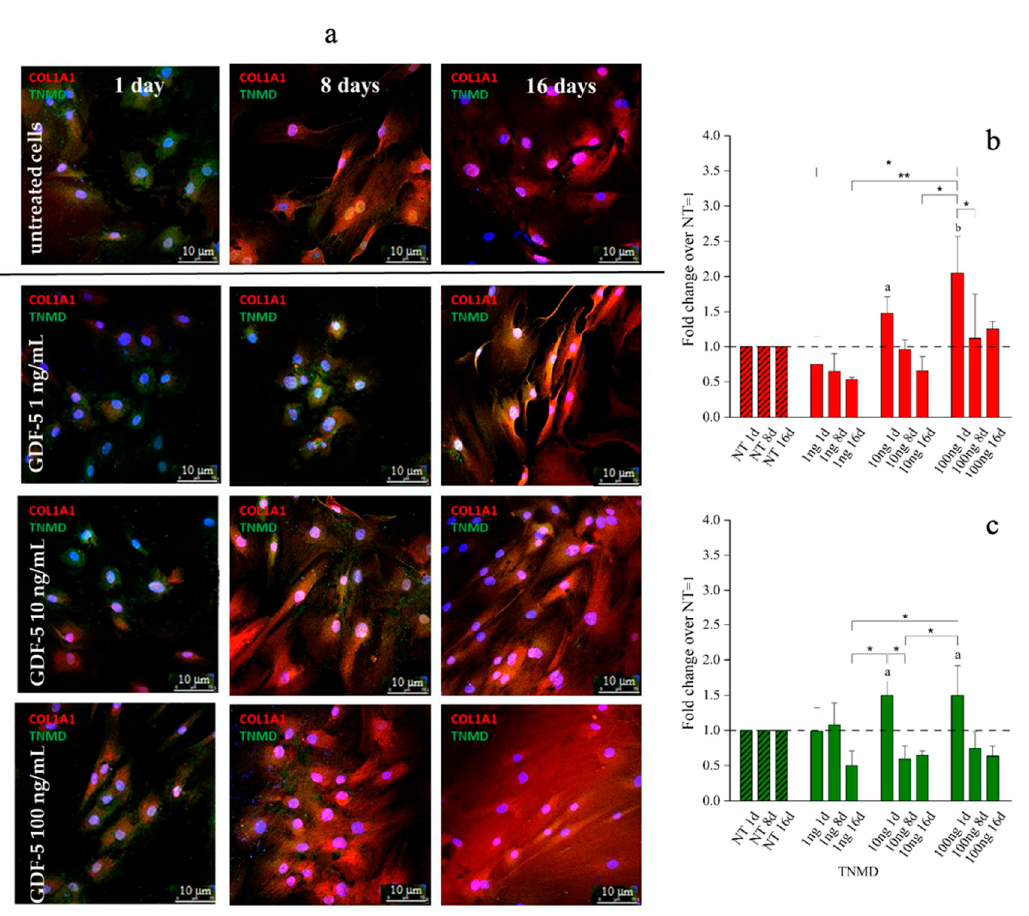
Figure 5. Immunofluorescence (IF) images and quantitative immunofluorescence (q-IF) data illustrating the effect of different hGDF-5 dose on hBM-MSCs. The panel ( a ) shows type 1 collagen (red staining) and tenomodulin (green staining) proteins up to 16 days of culture. Quantitative data on type 1 collagen ( b ) and tenomodulin ( c ) proteins were also reported; untreated cells (NT) are illustrated for comparison purpose. Statistically significant differences are shown as * = p ≤ 0.05; ** = p ≤ 0.01; *** = p ≤ 0.005; **** = p ≤ 0.001; a = p ≤ 0.05, b = p ≤ 0.01 compared to NT. (T0 = day 0; NT = untreated cells; 1ng = 1 ng/mL of hGDF-5; 10 ng = 10 ng/mL of hGDF-5; 100 ng = 100 ng/mL of hGDF- 5; d = days).